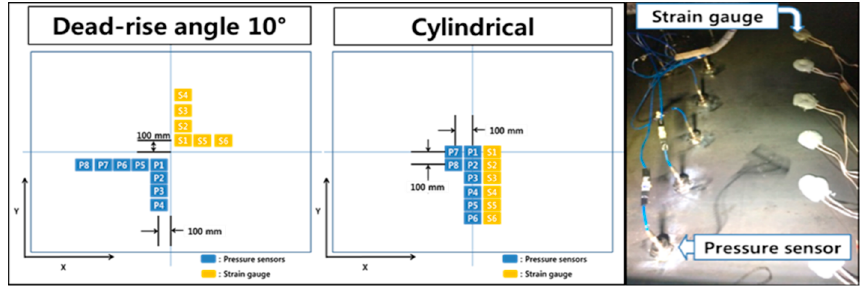
Figure 5. Locations of the sensors.